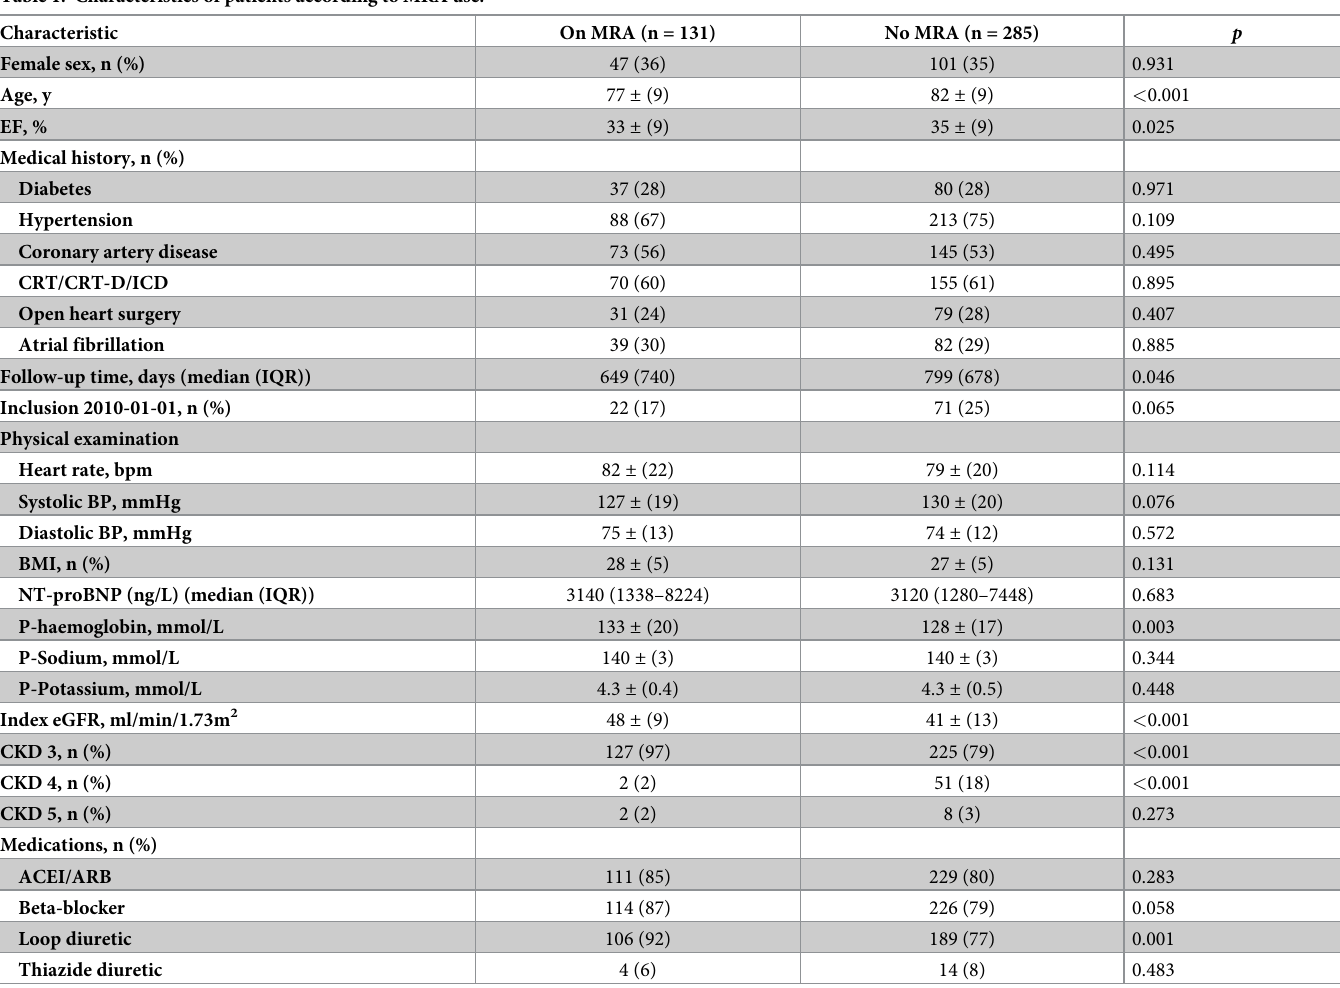
Table 1. Characteristics of patients according to MRA